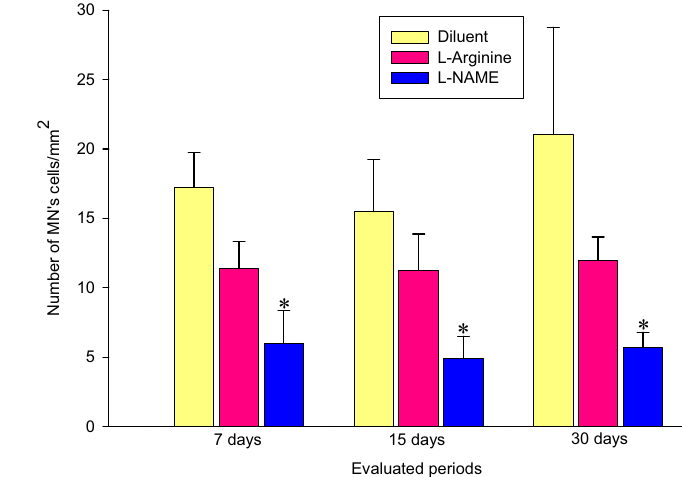
FIGURE 3 - Influence of L-Arginine and L-NAME treatments on tumor stroma.